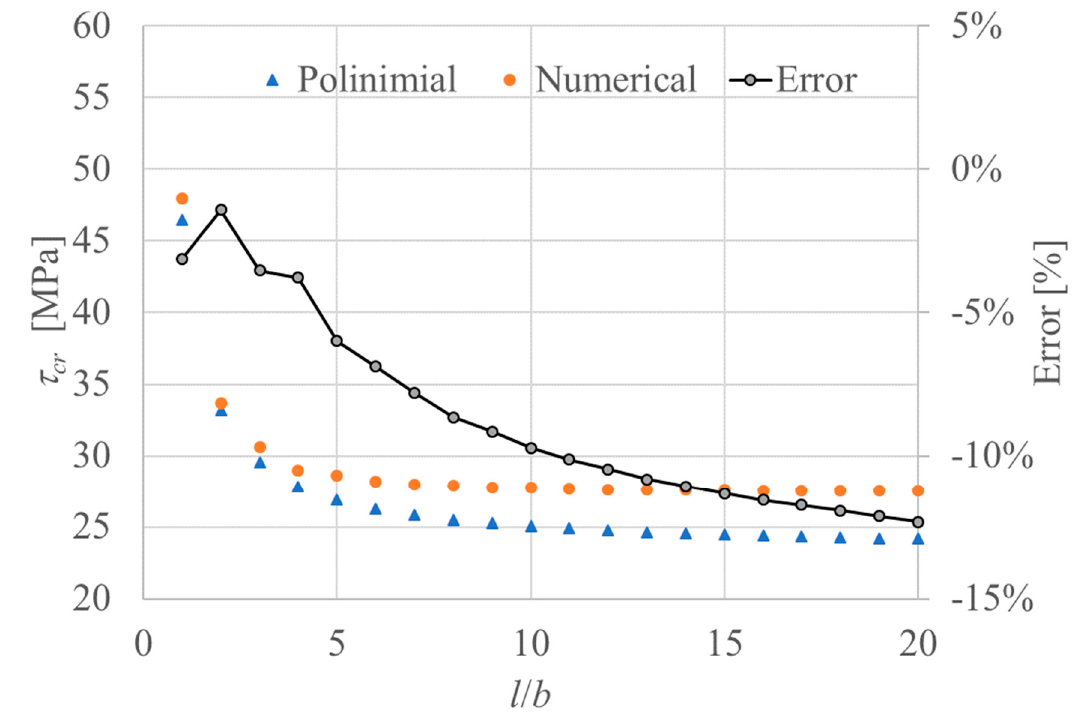
Figure 10. Comparison of polynomial and numerical